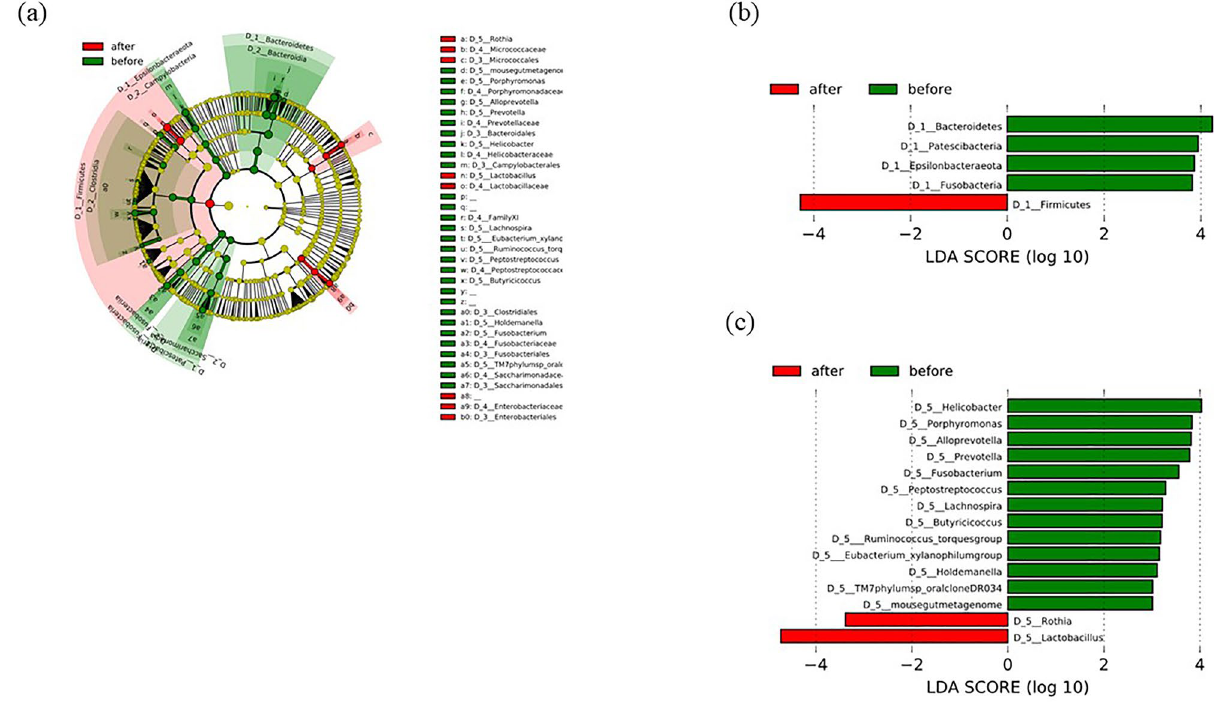
Figure 6. Differences in the abundance of bacterial genera before and after distal gastrectomy (DG) identified by linear discriminant analysis (LDA) effect size. ( a ) Cladogram of differentially abundant bacterial taxa in which each layer represents a different taxonomy. The enriched taxa of the gastric microbiome after DG are illustrated in the cladogram. The central point represents the tree’s root (Bacteria), and each ring represents the next lowest taxonomic level (phylum to genus: 1, phylum; 2, class; 3, order; 4, family; 5, genus). Each circle’s diameter represents the relative abundance of taxa. ( b ) LDA scores of phylum levels. ( c ) LDA score at the genus level. Histogram of LDA scores for differentially abundant bacterial taxa before and after DG. LDA score ≥ 3.0 is shown. Red represents significantly abundant taxa before DG compared to those after DG. Green represents the most abundant taxa after DG.